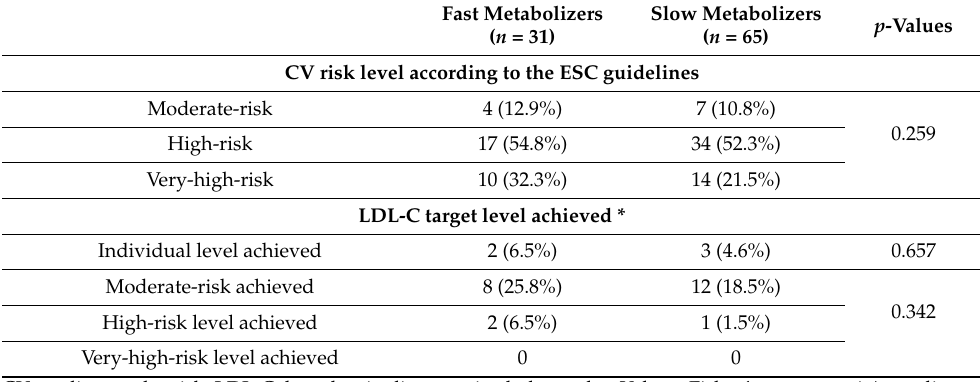
Table 3. Cardiovascular risk and achieved LDL-C levels.